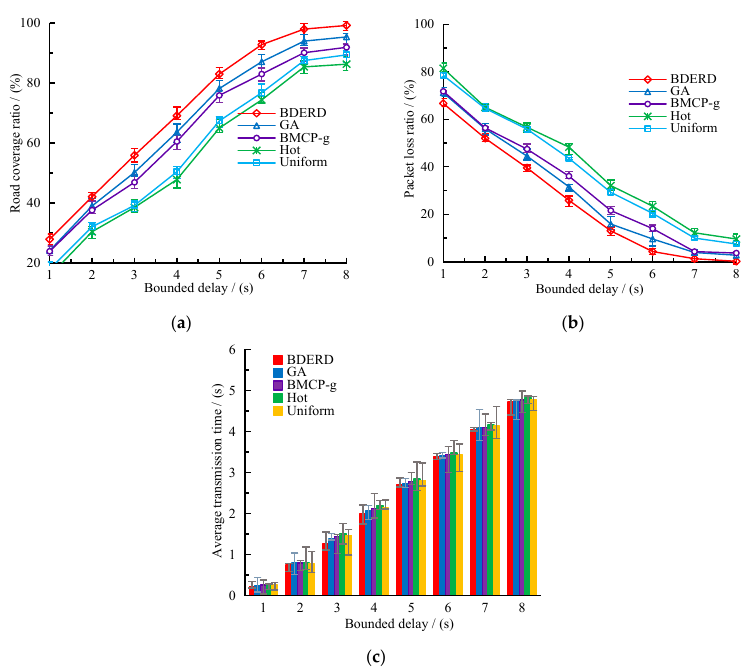
Figure 10. Realistic simulation. ( a ) Road coverage ratio versus bounded delay; ( b ) packet loss ratio versus bounded delay; ( c ) average transmission time versus bounded delay.